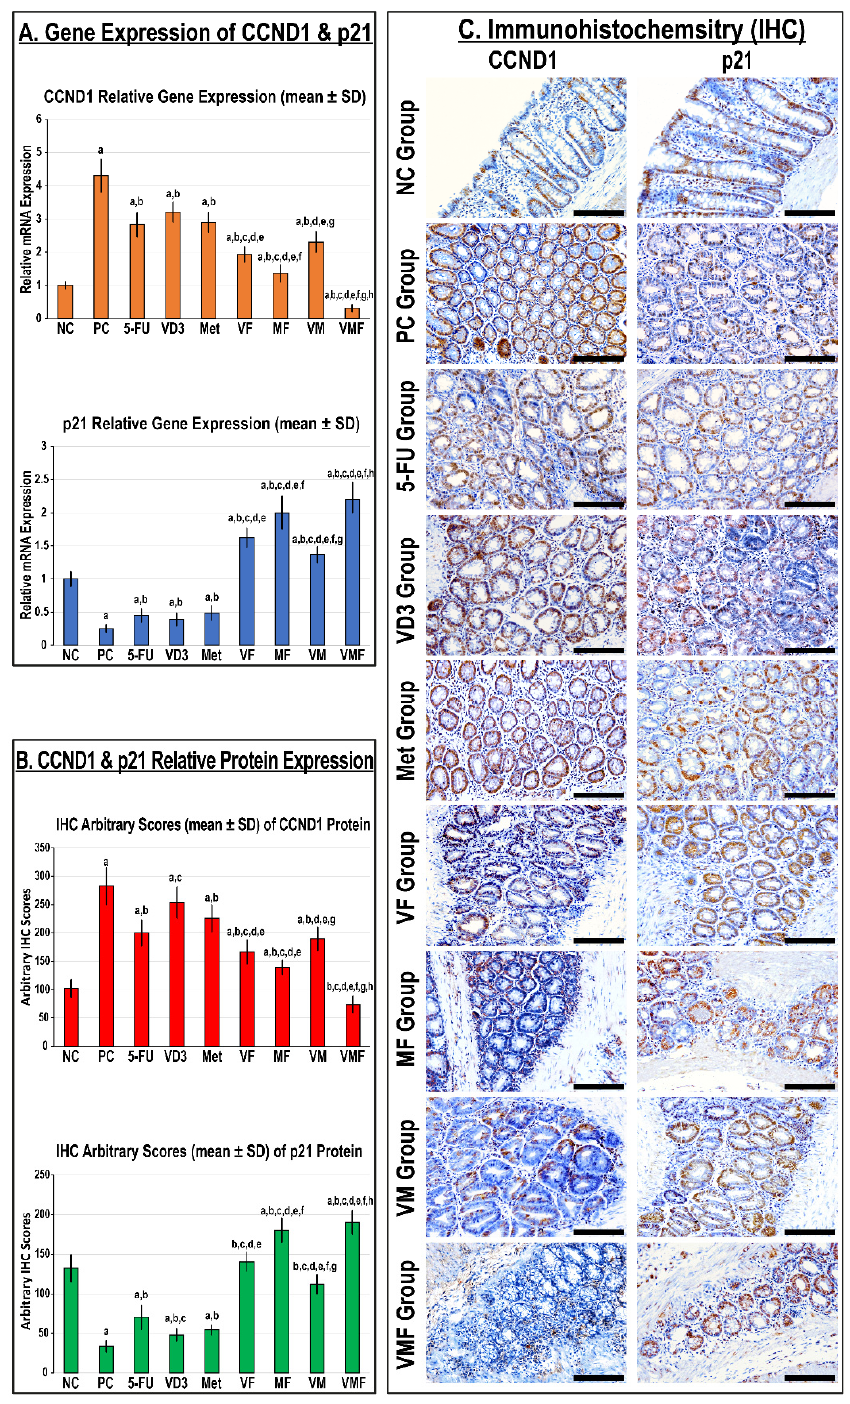
Figure 2. The relative ( A ) gene and ( B ) protein expression of CCND1 and p21 molecules in colonic tissues from the different groups is shown as bar graphs (n = 10 mice/group; data were analysed by ANOVA followed by Tukey’s HSD post hoc test and are shown as the mean ± SD; a = p < 0.05 compared with the NC group; b = p < 0.05 compared with the PC group; c = p < 0.05 compared with 5-FU monotherapy; d = p < 0.05 compared VD 3 monotherapy; e = p < 0.05 compared with Met monotherapy; f = p < 0.05 compared with VF dual therapy; g = p < 0.05 compared with MF dual therapy; and h = p < 0.05 compared with VM dual therapy). ( C ) Localisation of CCND1 and p21 proteins by immunohistochemistry (IHC) in colonic tissues from the different groups (n = 10 mice/group; 20 × objective; scale bar = 15 µ